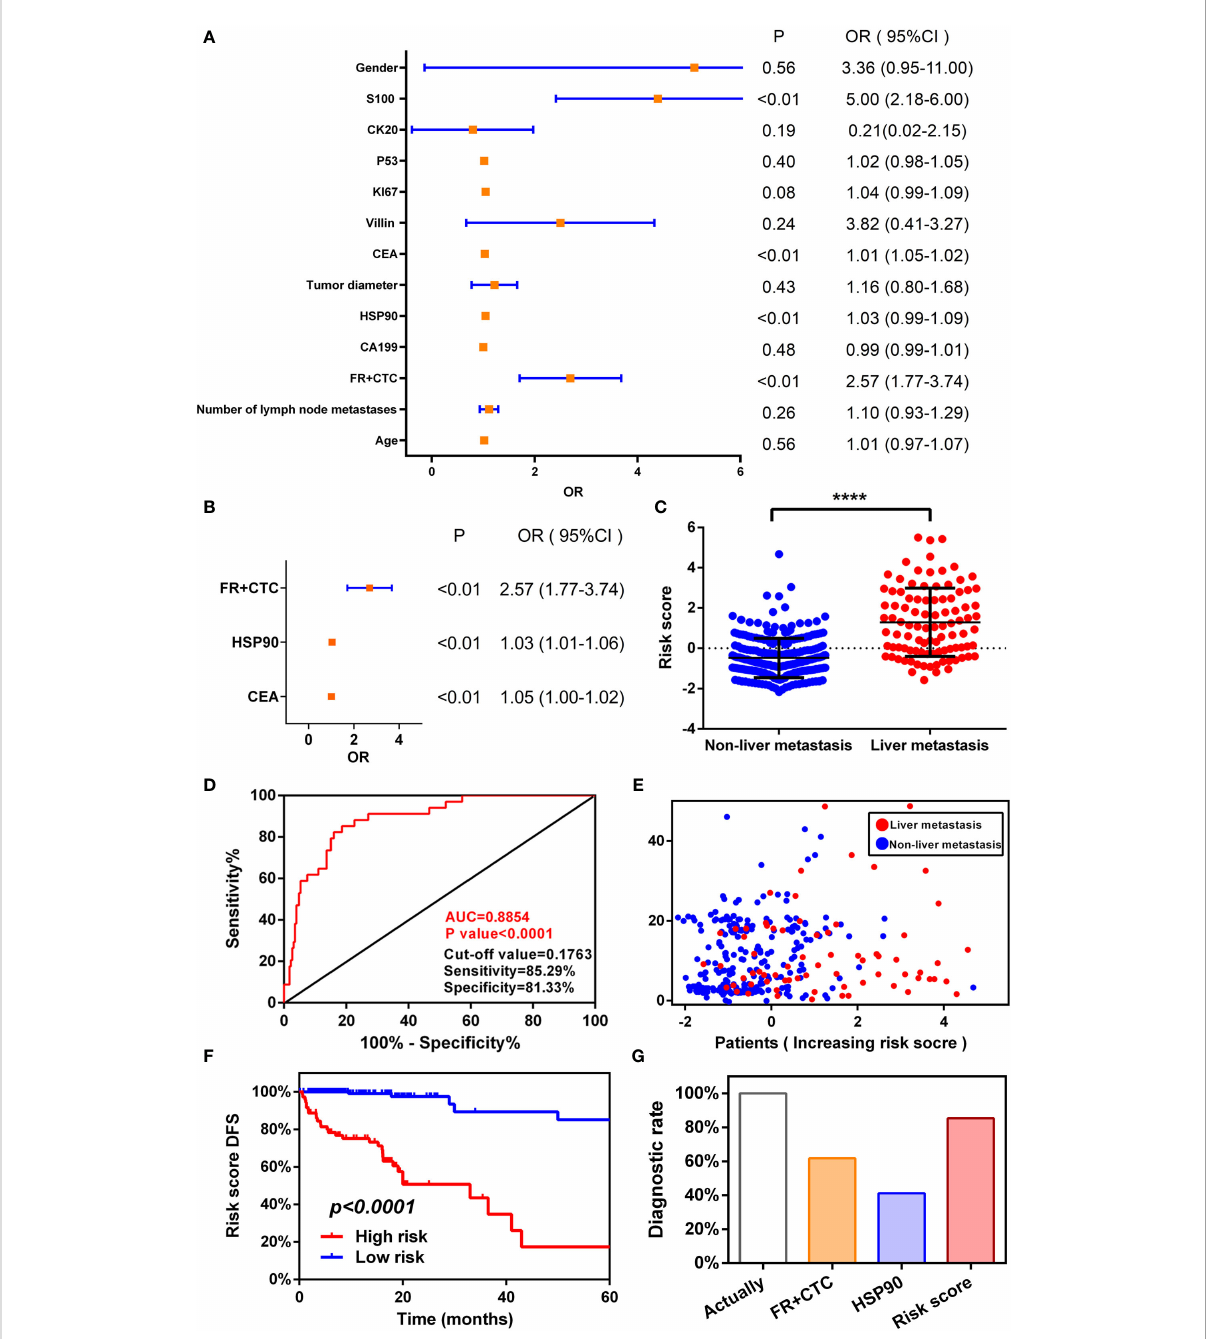
FIGURE 4 Establishing a logistic regression risk assessment model. Univariate (A) and multivariate (B) analyses of risk factors for liver metastasis of colorectal cancer. (C) Receiver operating characteristic (ROC) curve of risk scoring model. (D) Risk score model and survival scatter plot of patients with colorectal cancer. High risk of folate receptor plus circulating tumor cells (FR+CTC) (C) and heat shock protein 90 (HSP90) (D) predicts the median disease-free survival (mDFS) of liver metastatic colorectal cancer. (E) High- and low-risk scores predict mDFS in patients with colorectal cancer liver metastases. (F) Comparison of diagnostic ability between risk model and single